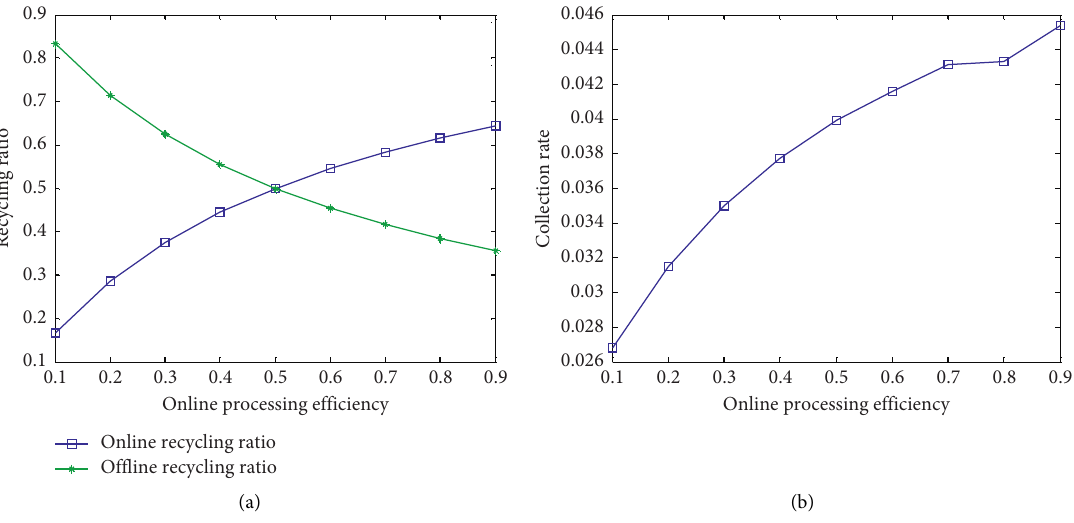
Figure 15: Online recycling efficiency analysis chart. (a) Online processing efficiency and recycling ratio. (b) Online processing efficiency and collection rate